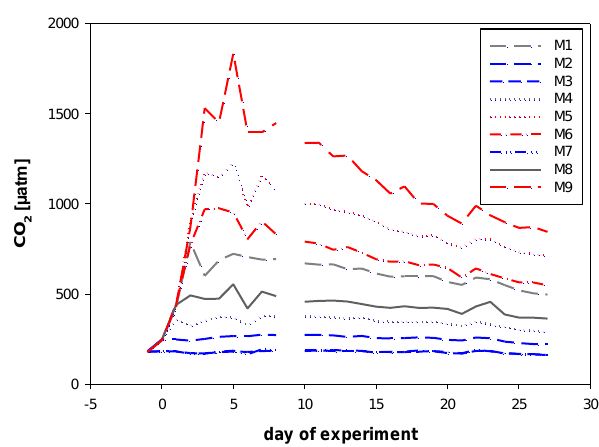
Fig. 1. Development of p CO 2 (µatm) in the nine mesocosms during the course of the Svalbard